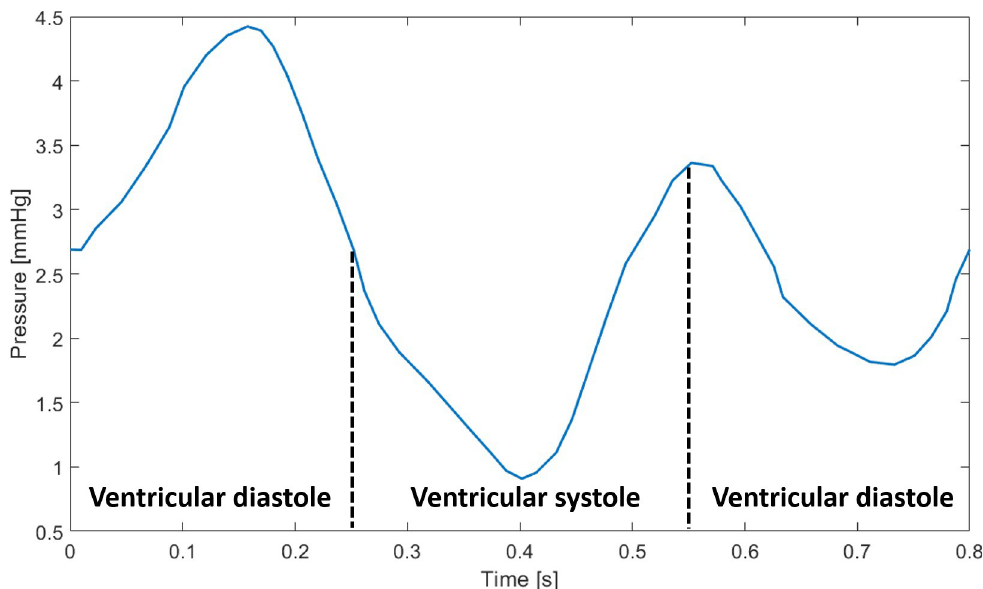
Fig 7. Time-dependent pressure, with diastolic and systolic periods represented, imposed at the inlets (adapted from Cohen et al . 1986). This boundary condition can be generated with the code from the S8 File.